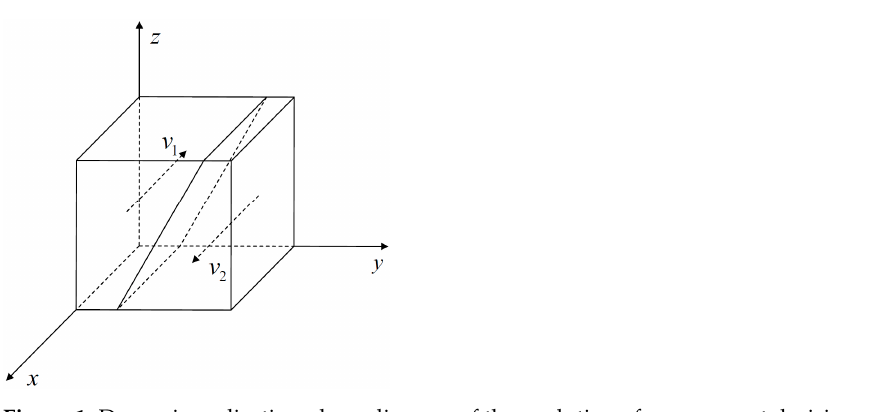
Figure 1. Dynamic replication phase diagram of the evolution of government decision-making.